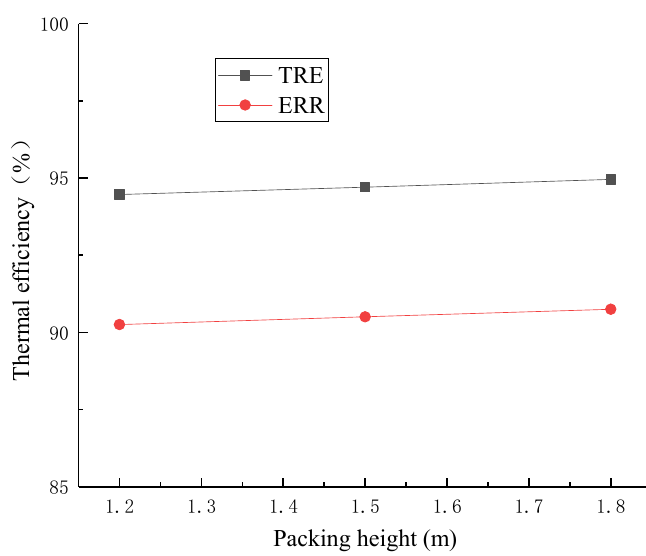
Figure 12. Effect of the numbers of regenerative media channels on heat transfer efficiencies.